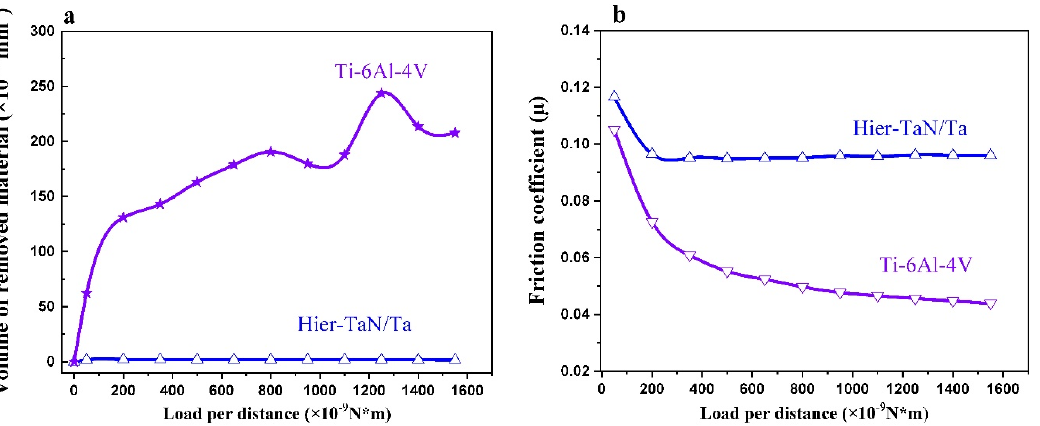
Figure 6. ( a ) Volume of removed material and ( b ) friction coefficient of Ti-6Al-4V and Hier-TaN/Ta coating.